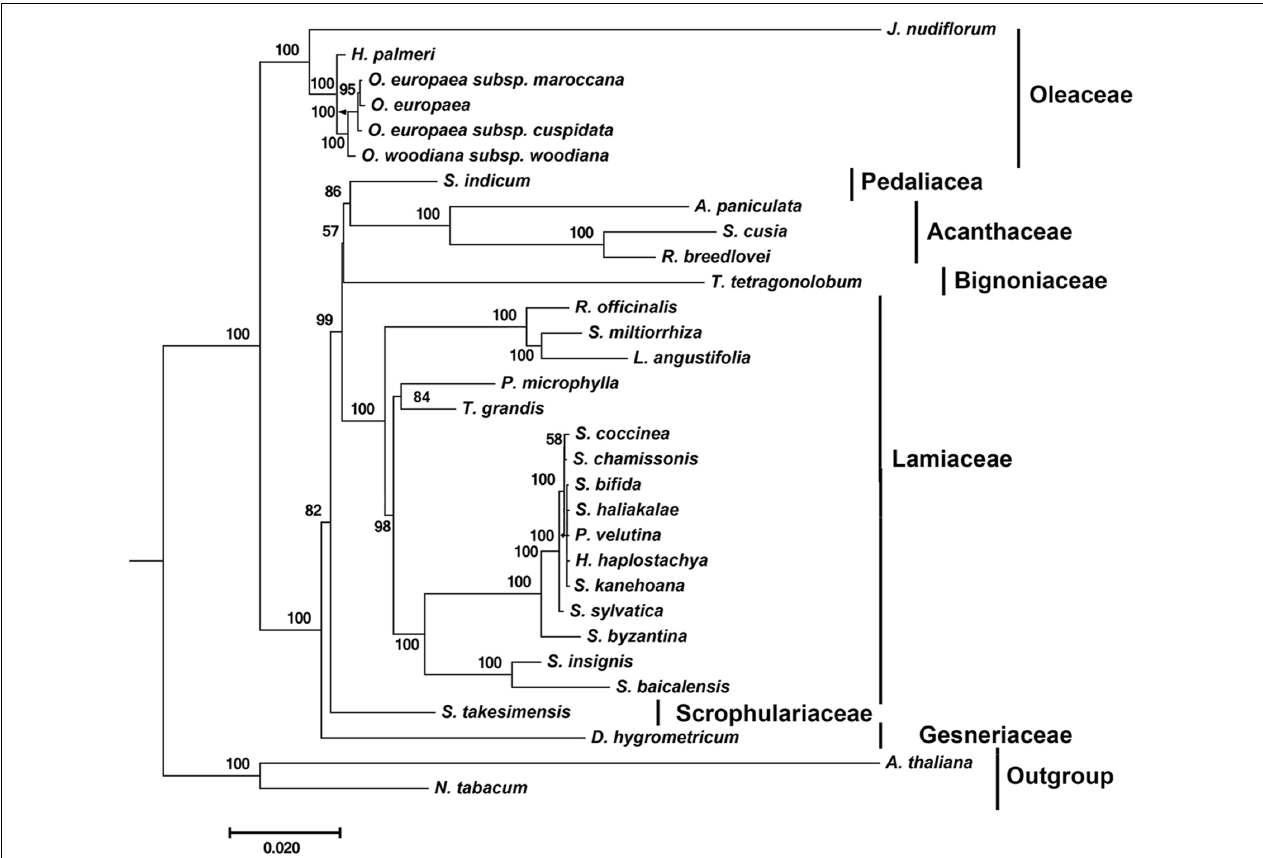
FIGURE 4 | Molecular phylogenetic analyses of cp genomes in the Lamiales order. The tree was constructed with the sequences of 65 proteins present in 31 species ( A. paniculata , R. breedlovei , T. tetragonolobum , D. hygrometricum , H. haplostachya , L. angustifolia , Phyllostegia velutina , Premna microphylla , R. officinalis , S. miltiorrhiza , S. baicalensis , S. insignis , S. byzantina , S. chamissonis , S. coccinea , S. sylvatica , S. bifida , S. haliakalae , S. kanehoana , T. grandis , H. palmeri , J. nudiflorum , O. europaea , O. europaea subsp. Cuspidata, O. europaea subsp. Maroccana, O. woodiana subsp. woodiana , S. indicum , S. takesimensis , Strobilanthes cusia , A. thaliana , and N. tabacum ) using the Maximum Likelihood method implemented in RAxML. Two taxa, N. tabacum and A. thaliana , were used as outgroups. Tribes to which each species belongs are shown to the right side of the tree. Bootstrap supports were calculated from 1000